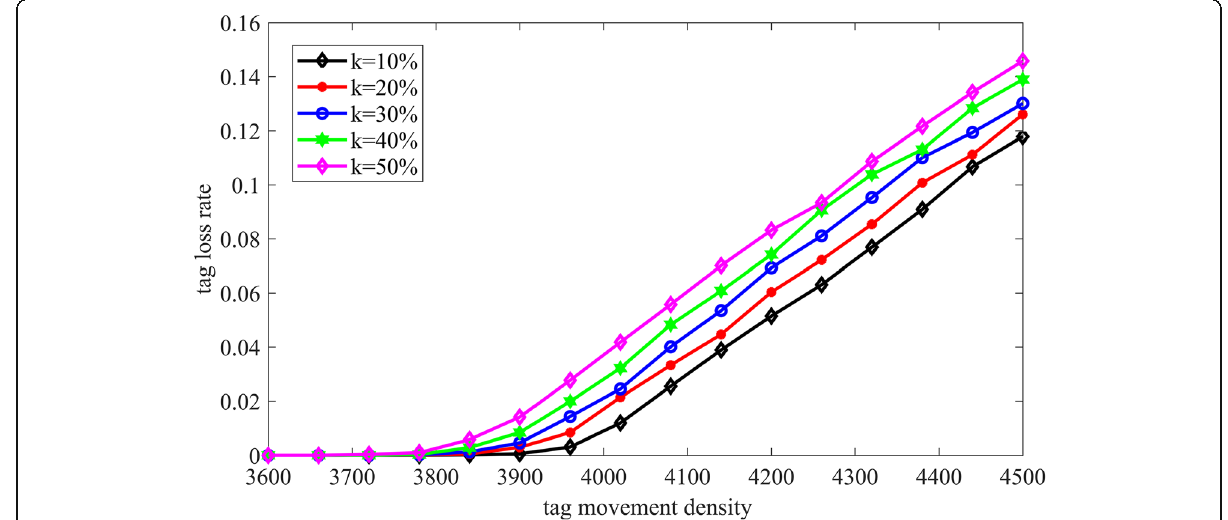
Fig. 17 Comparison of TLR between different SRP